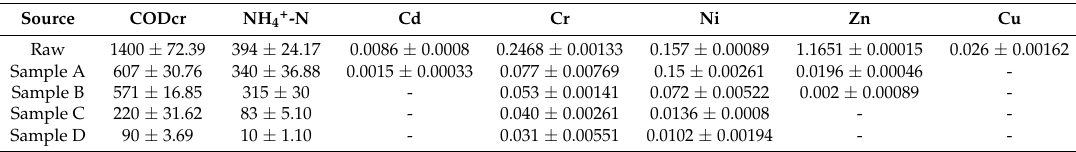
Table 3. Integrated efficiency process parameters (mg/L).